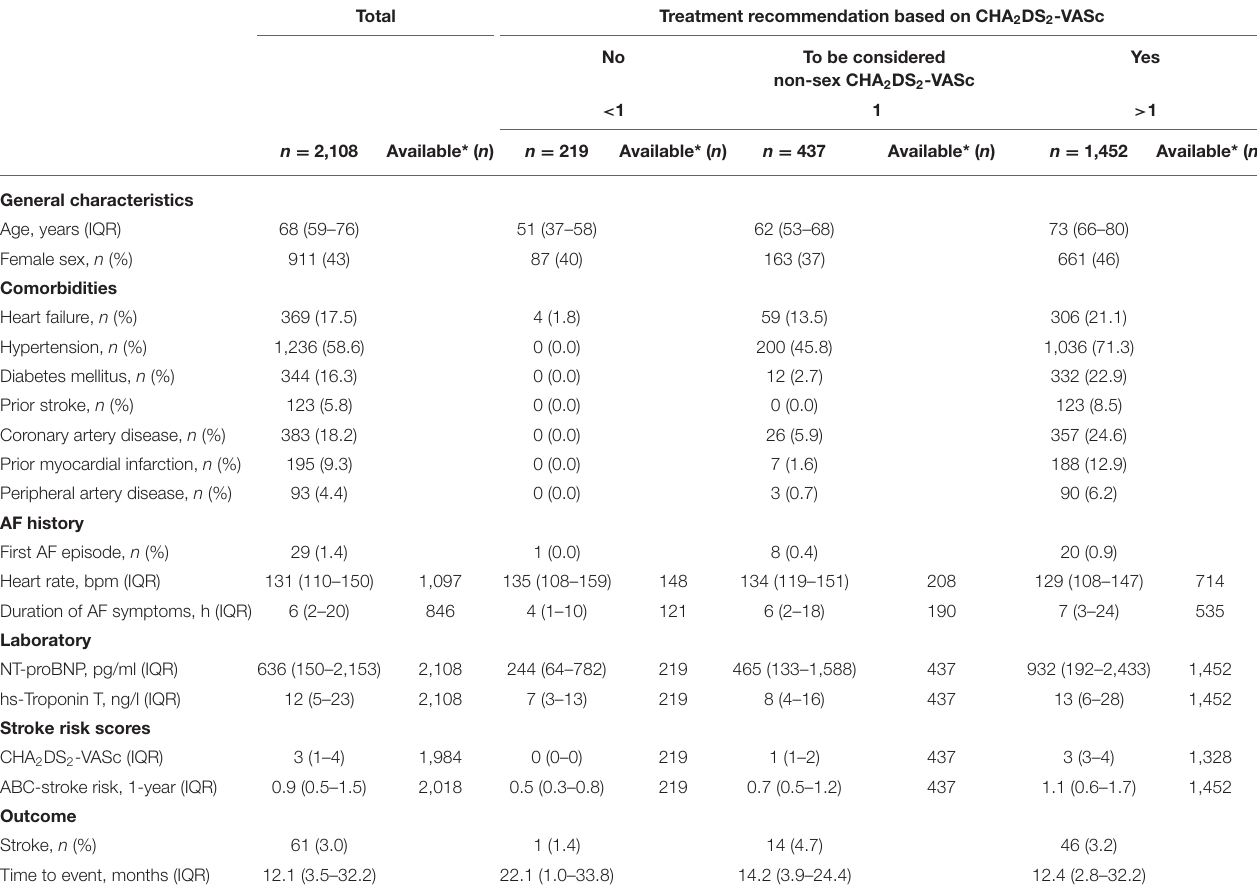
TABLE 1 | Demographics and baseline characteristics of study patients by CHA 2 DS 2 -VASc risk classes.